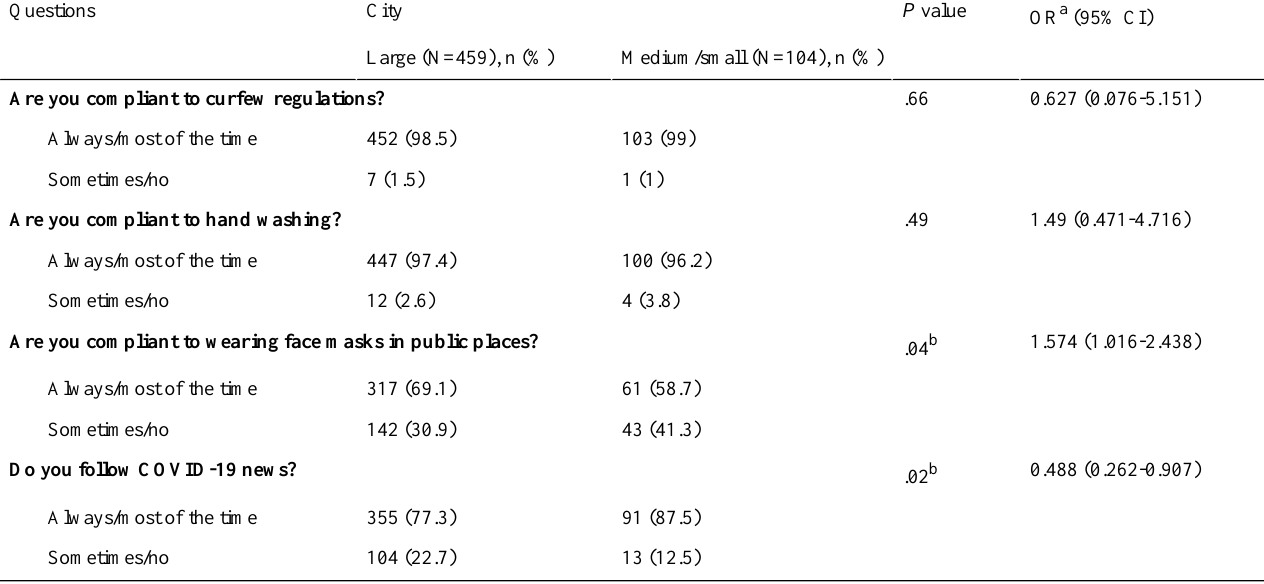
Table 4. Comparison of the attitude toward COVID-19 among health care workers in large, medium, and small cities in Saudi Arabia